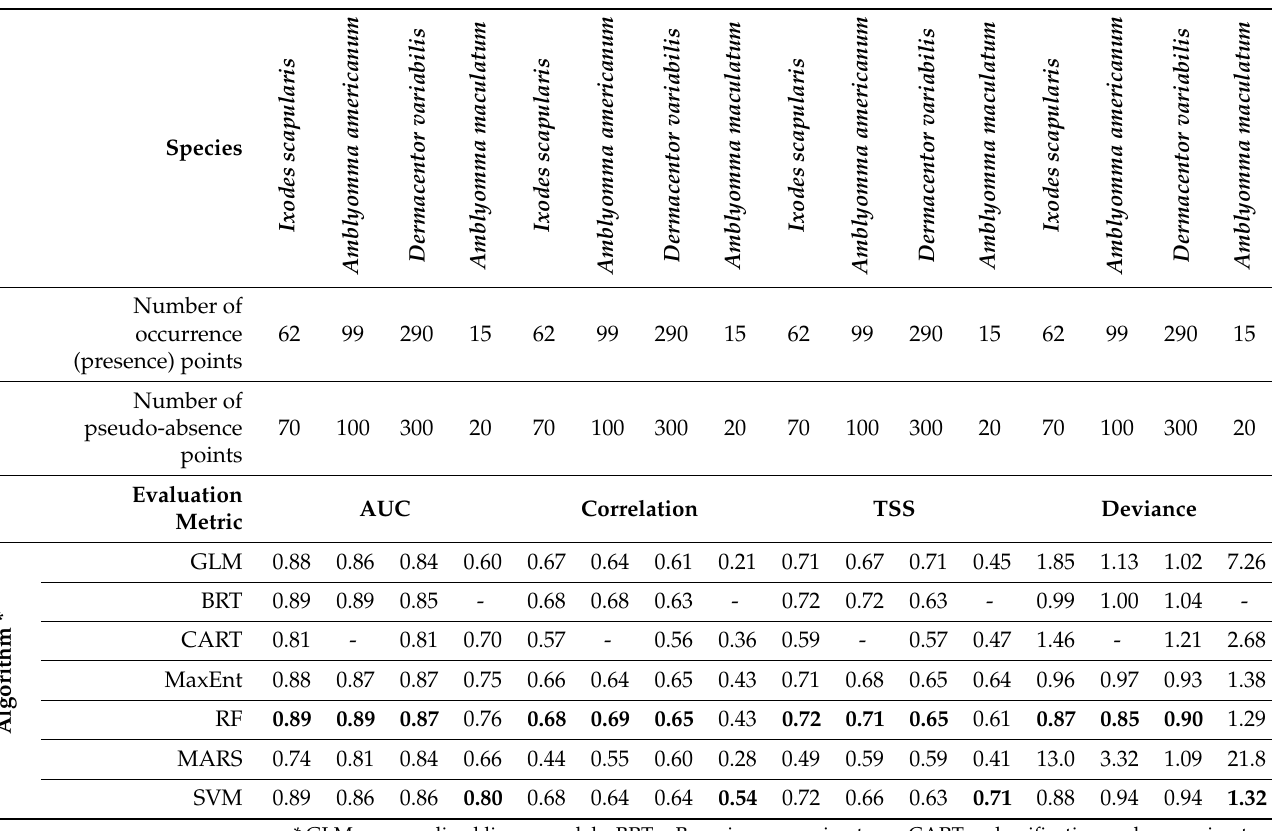
Table 2. Mean best fit single model evaluation metrics for the predicted historic occurrence in Illinois of the four tick species modeled. Bolded numbers denote the AUC/correlation/true skill statistic (TSS) score/deviance for the best fit model for that species. To be included in ensemble models, an individual model must display an AUC of at least 0.75 and a TSS of at least 0.50. A dash indicates that an algorithm did not display a complete (100%) model run success percentage for that period.